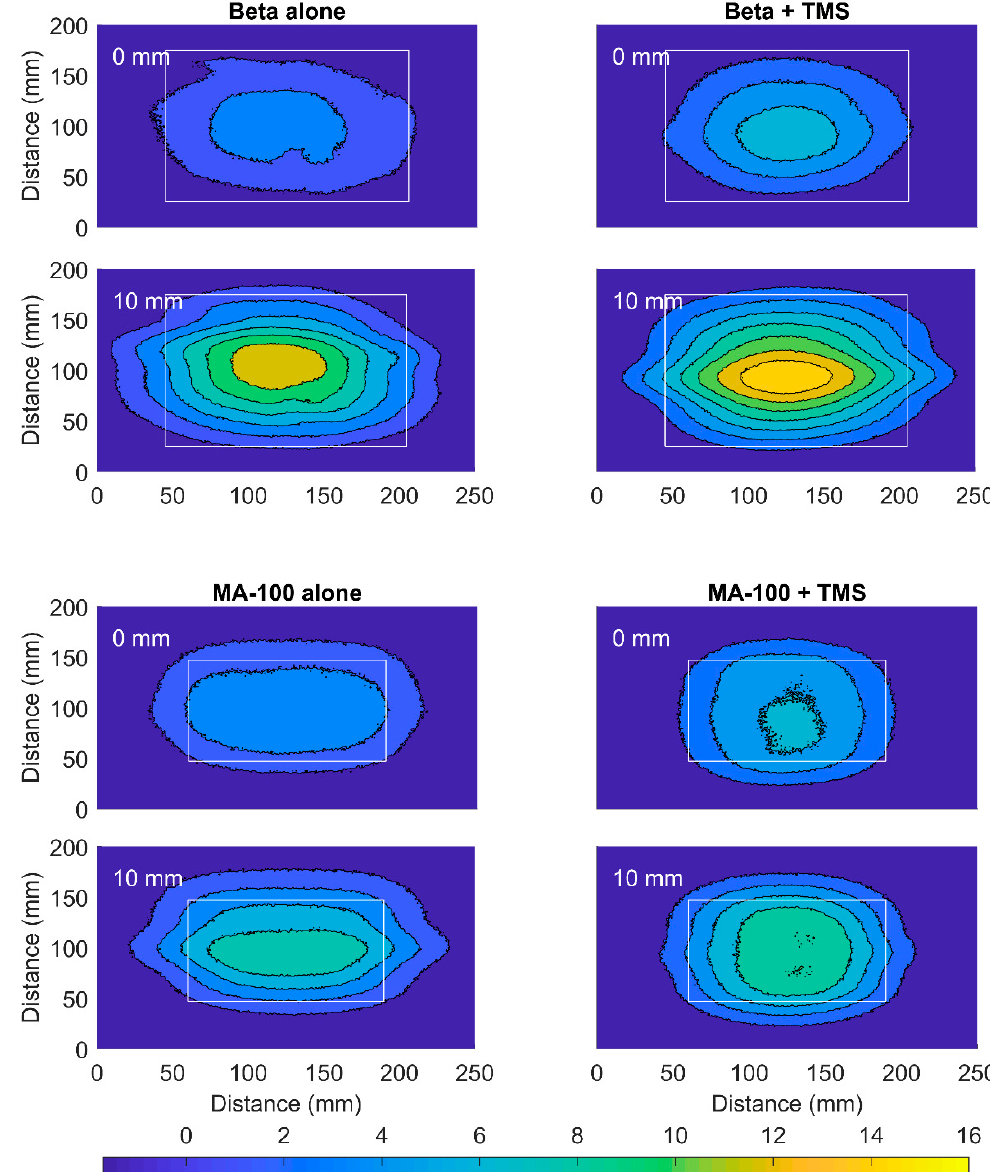
Figure 7. The infrared temperature data of the power deposition pattern of the Beta (51.0 W at 434 MHz; Medlogix, Rome, Italy) and MA-100 (44.1 W at 915 MHz; Pyrexar, Salt Lake City, USA) applicators. The temperature rise on the surface of the fat-equivalent layer is shown (0 mm) and at 10 mm depth on the surface of the muscle-equivalent phantom (10 mm). Results are displayed for the applicator alone (left) and the applicator combined with the thermal monitoring sheet (TMS; right). The aperture dimensions are represented by the white rectangle.